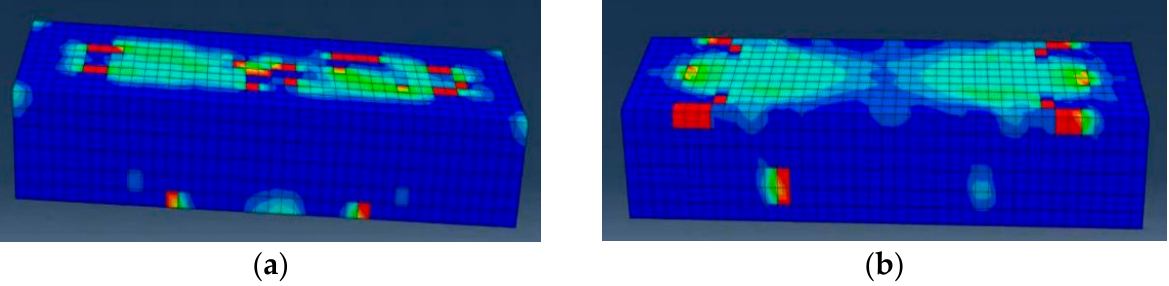
Figure 21. Fatigue life map of reinforced components under different freeze–thaw cycles: ( a ) 50 freeze–thaw cycles; ( b ) 100 freeze–thaw cycles.